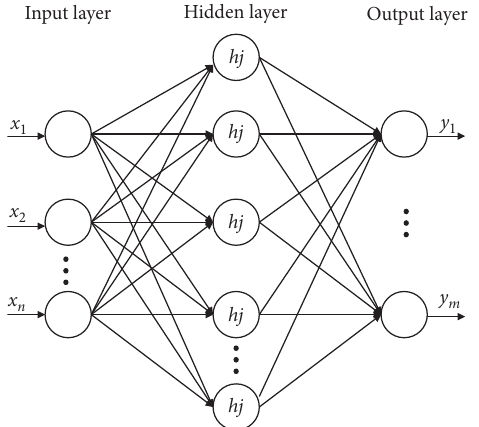
Figure 1: The Gplot of the wavelet neural network (WNN)